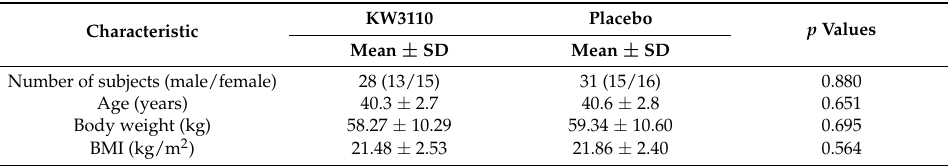
Table 2. Baseline characteristics of subjects analyzed in the